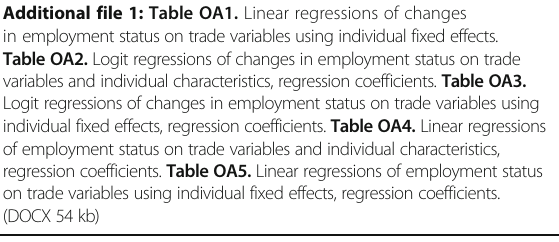
Table OA2. Logit regressions of changes in employment status on trade variables and individual characteristics, regression coefficients. Table OA3. Logit regressions of changes in employment status on trade variables using individual fixed effects, regression coefficients. Table OA4. Linear regressions of employment status on trade variables and individual characteristics, regression coefficients. Table OA5. Linear regressions of employment status on trade variables using individual fixed effects, regression coefficients. (DOCX 54 kb)